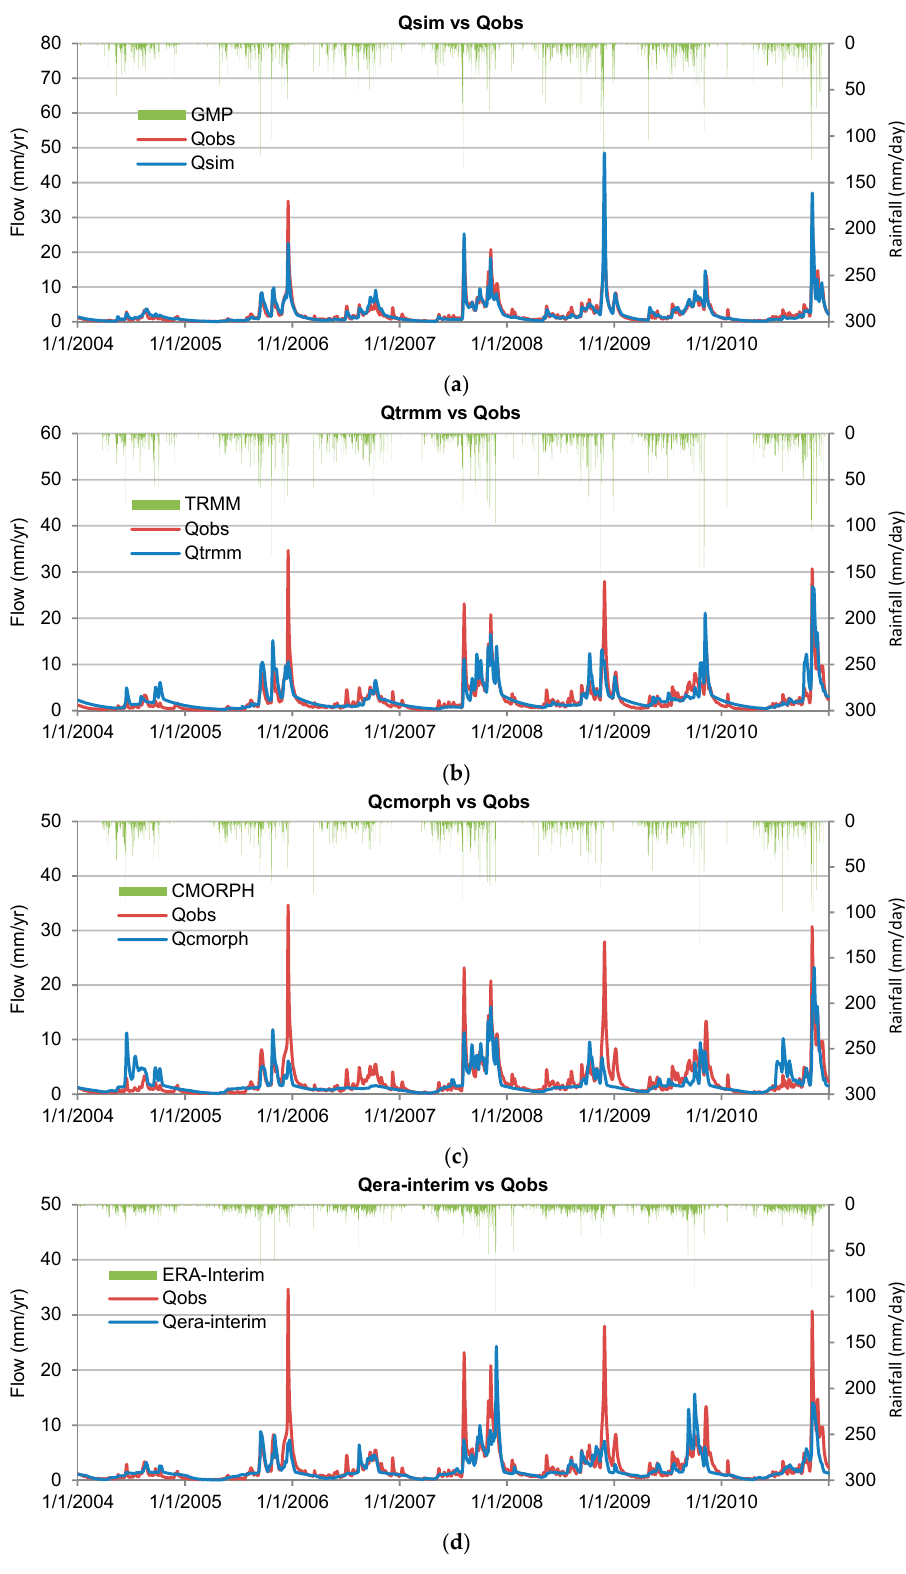
Figure 7. Hydrographs comparing simulated and observed flow at daily time scale based on rainfall input data from ( a ) GMP; and the SBRP; ( b ) Tropical Rainfall Measuring Mission (TRMM); ( c ) Climate Prediction Center for morphing method (CMORPH); and ( d ) ERA-Interim for calibration period (January 2004–December 2007) and validation period (January 2008–December 2010).